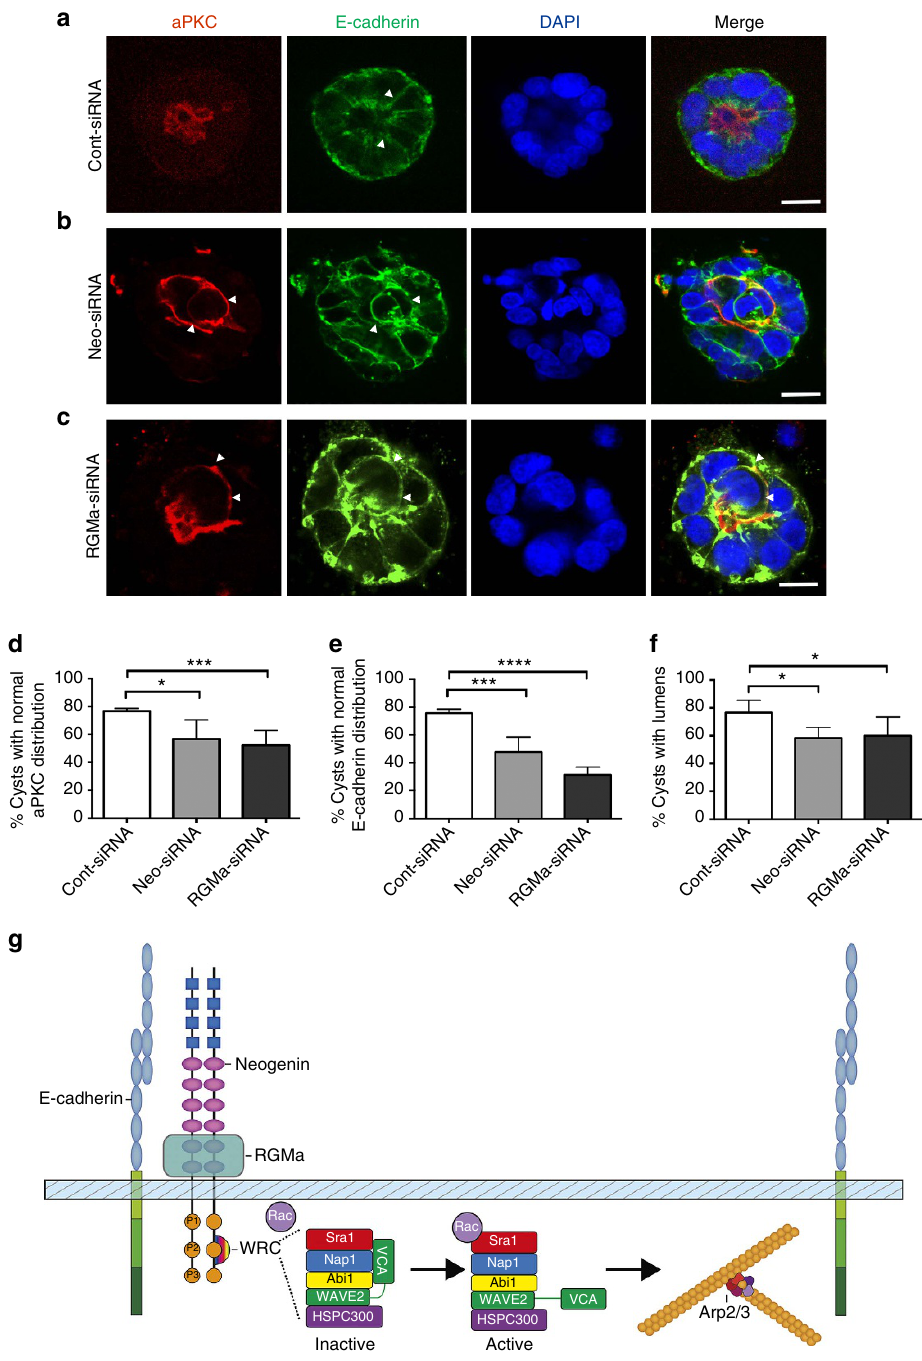
Figure 8 | RGMa and Neogenin control Caco-2 epithelial cyst morphogenesis. Representative confocal micrographs of Caco-2 cysts after transfection of ( a ) Cont-siRNA (arrowheads indicate Ecad þ junctions), ( b ) Neo-siRNA or ( c ) RGMa-siRNA. ( b , c ) Arrowheads indicate cells that have undergone extrusion. ( d ) Quantification of the number of cysts displaying normal apical aPKC distribution ( n ¼ 30, * P o 0.05, *** P ¼ 0.001, one-way analysis of variance (ANOVA), Dunn’s post hoc test). ( e ) Quantification of the number of cysts displaying normal basolateral Ecad distribution ( n ¼ 30, *** P o